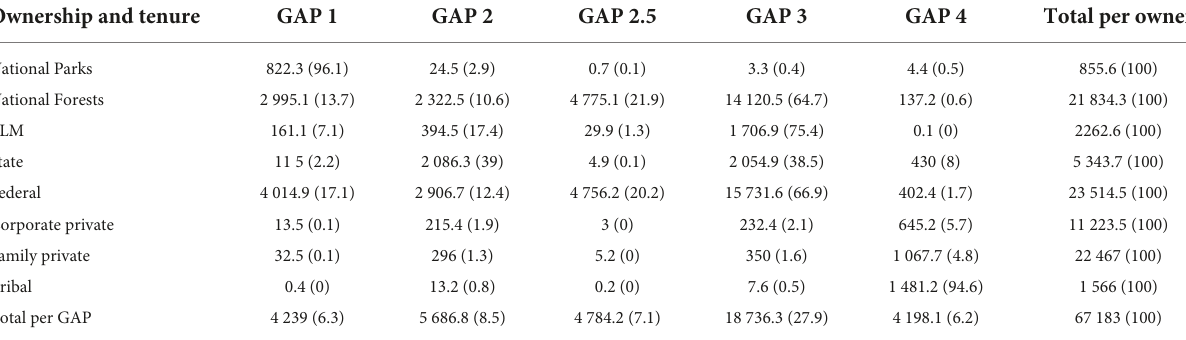
Percentagesarecalculatedacrossrows.GAP2.5referstoInventoriedRoadlessAreas(IRAs).IRAsoutsidenationalforestsareclassificationerrorsofinputdatasets.